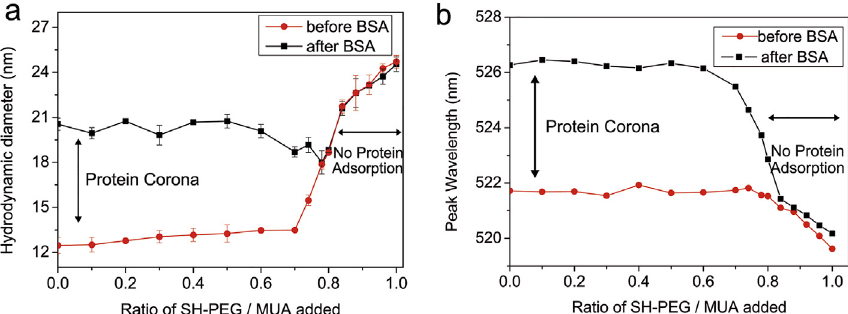
Figure 5 . Tuning the protein adsorption. (a) Hydrodynamic Diameter before and after incubation with BSA. The formation of a protein corona at lower ratios is clearly related to the increase of the hydrodynamic diameter. The increase of size is minimized from ratio 0.70. From ratios 0.78 to 1 this difference on size is negligible and therefore protein adsorption is totally inhibited. (b) SPR peak before and after incubation with albumin. The same behavior was found by analyzing the peak of the SPR band. The differences between before and after addition of albumin are reduced from ratios 0.7 to 0.8. From 0.84 to 1 the differences are negligible.